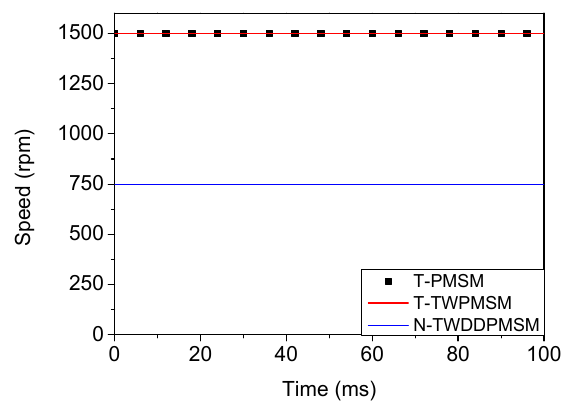
Figure 13. The speeds of the three motors.